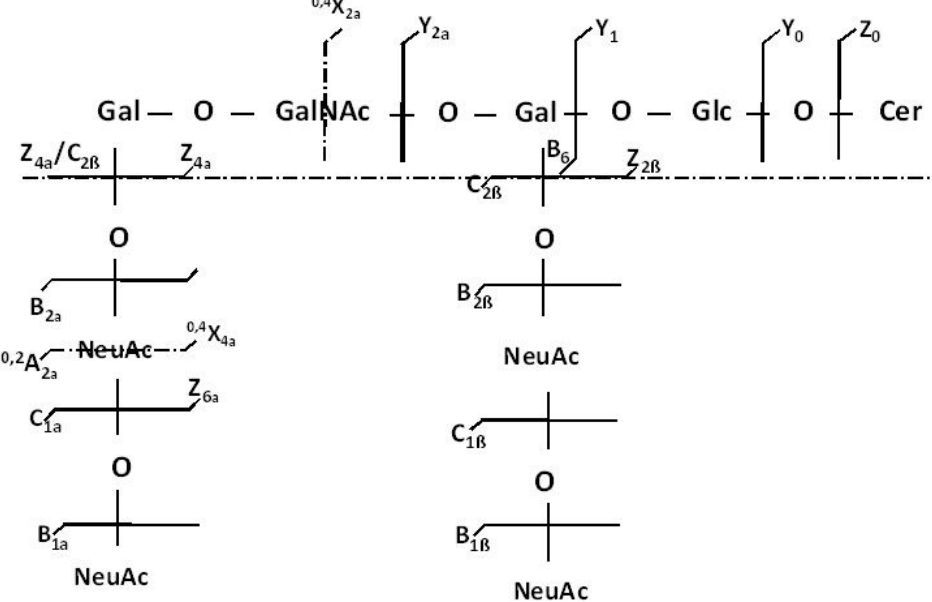
Figure 6. Fragmentation scheme by HCD MS/MS of the [M − 4H + ] 4 − detected at m/z 603.7844 and the generated product ions.